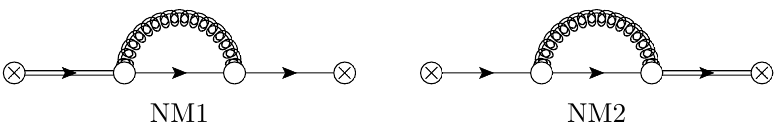
Figure 4. New next-to-leading order diagrams for the NMGF evolved fermion 2-point function. Combined with the diagrams from figure 10 they represent the full NMGF evolved fermion 2-point function, which is rendered finite by multiplying with the renormalization factor Z χ from (3.28). diagram value NM1 + NM2